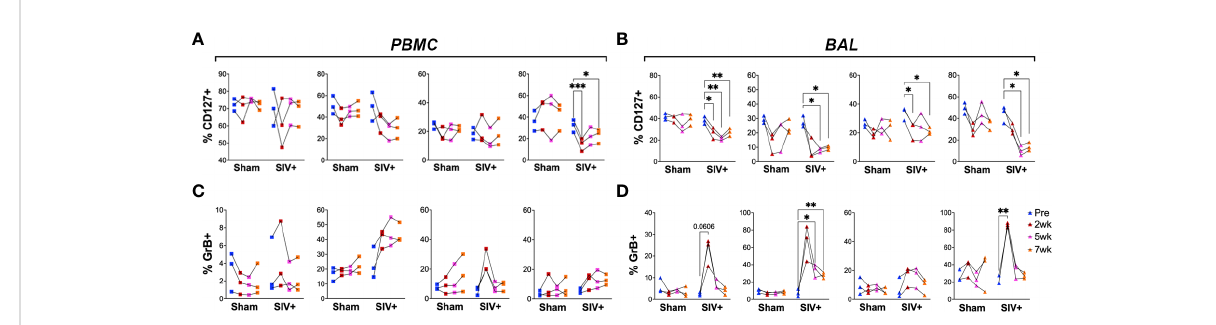
FIGURE 7 Impact of SIV infection on the expression of CD127 (IL-7R) and GrB on T cell subsets. Frequencies of CD4 T, CD8 T, DNT, and gd T cells in PBMCs (left panels A , C ) and BAL cells (right panels B , D ) expressing CD127 (top) and GrB (bottom). Comparisons of different time points with respect to pre-SIV baseline was carried out using repeated measures one-way ANOVA with Dunnett ’ s post hoc tests. Asterisks indicate signi fi cant differences between time points (*p < 0.05; **p < 0.01; ***p <